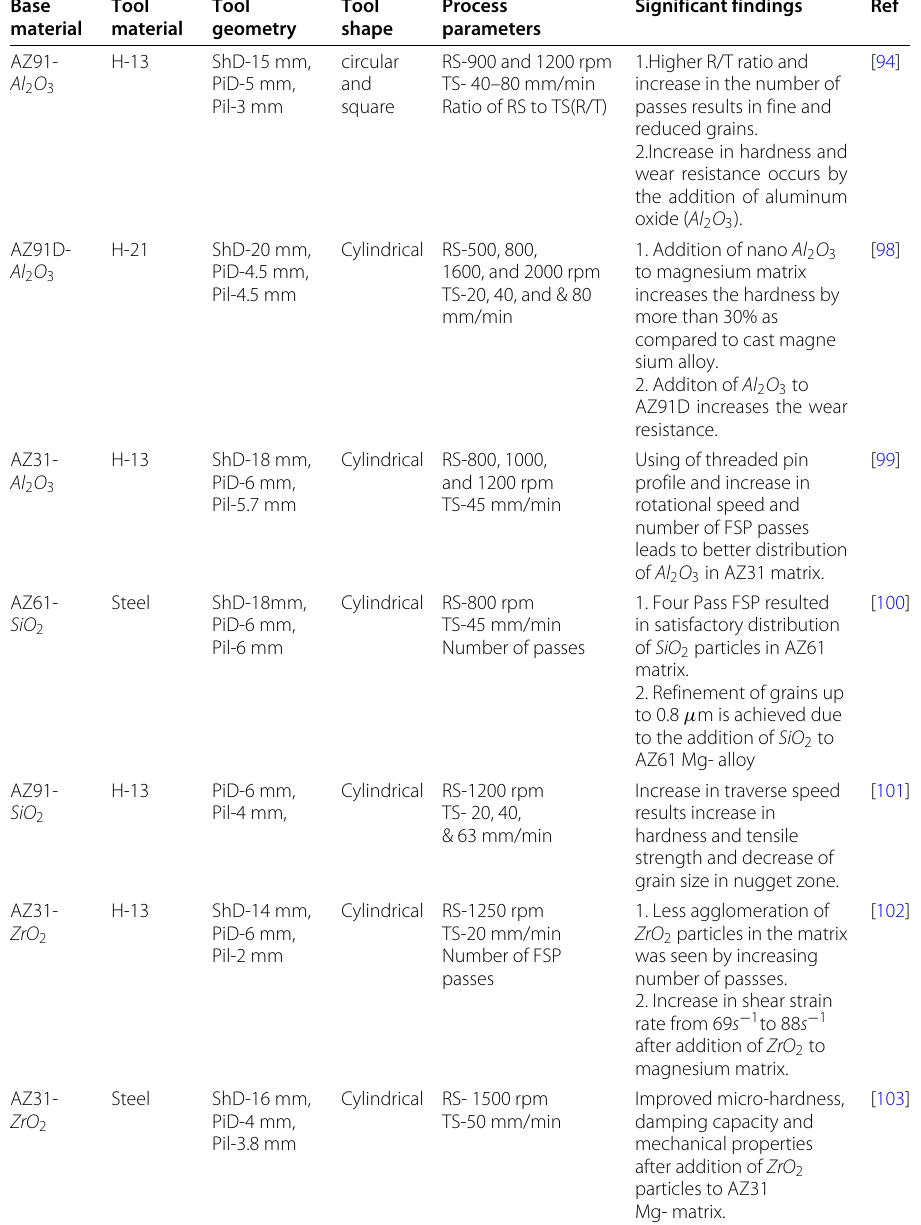
Table 3 Brief summary of Mg-MO surface MMCs by FSP as available in the literature Base